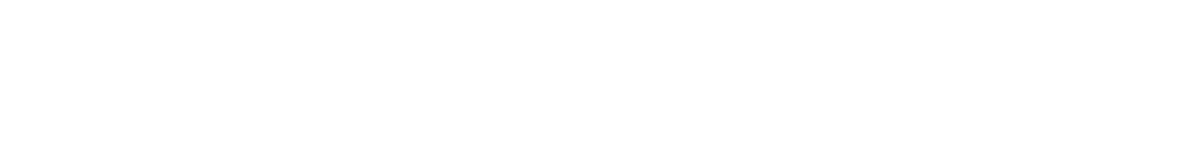
Frontiers in Bioengineering and Biotechnology |